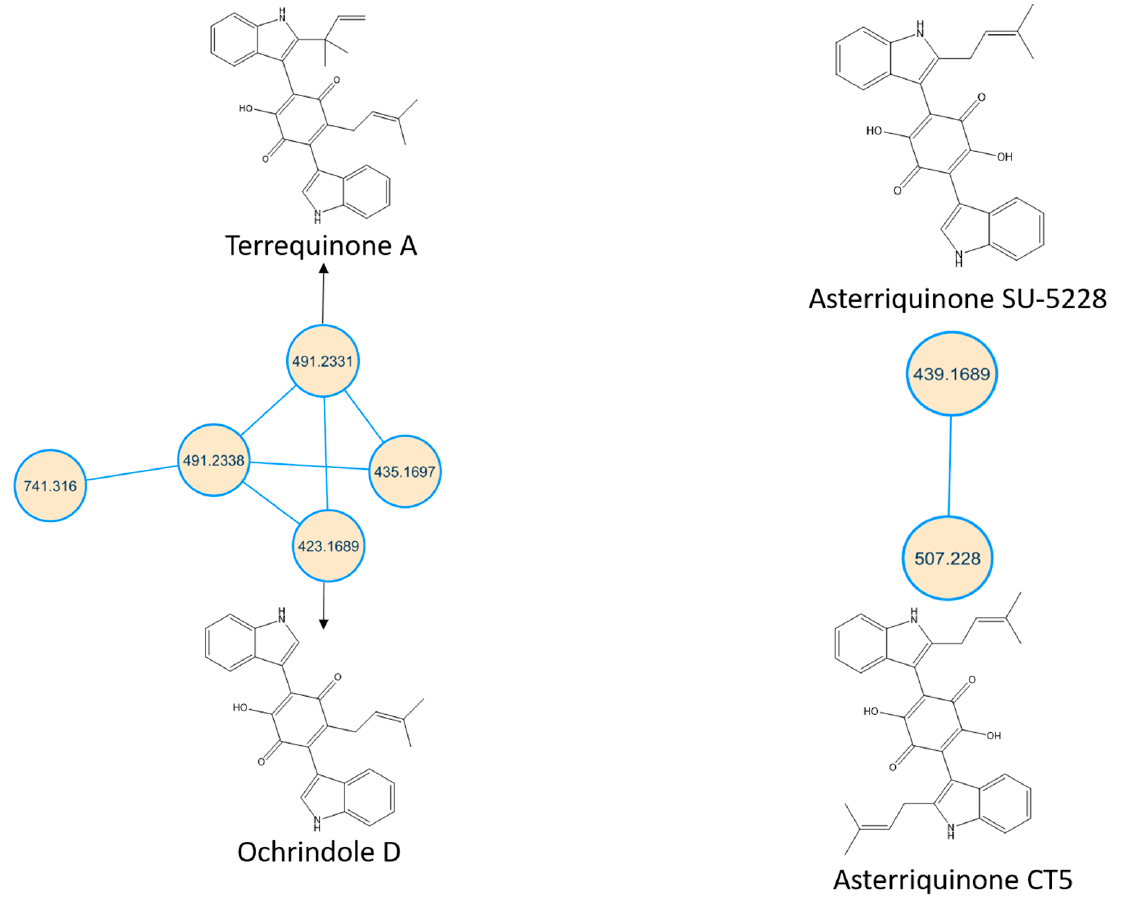
Figure 2. Terrequinone A and asterriquinones spectral families. The nodes label represents precursor mass ( m / z ).